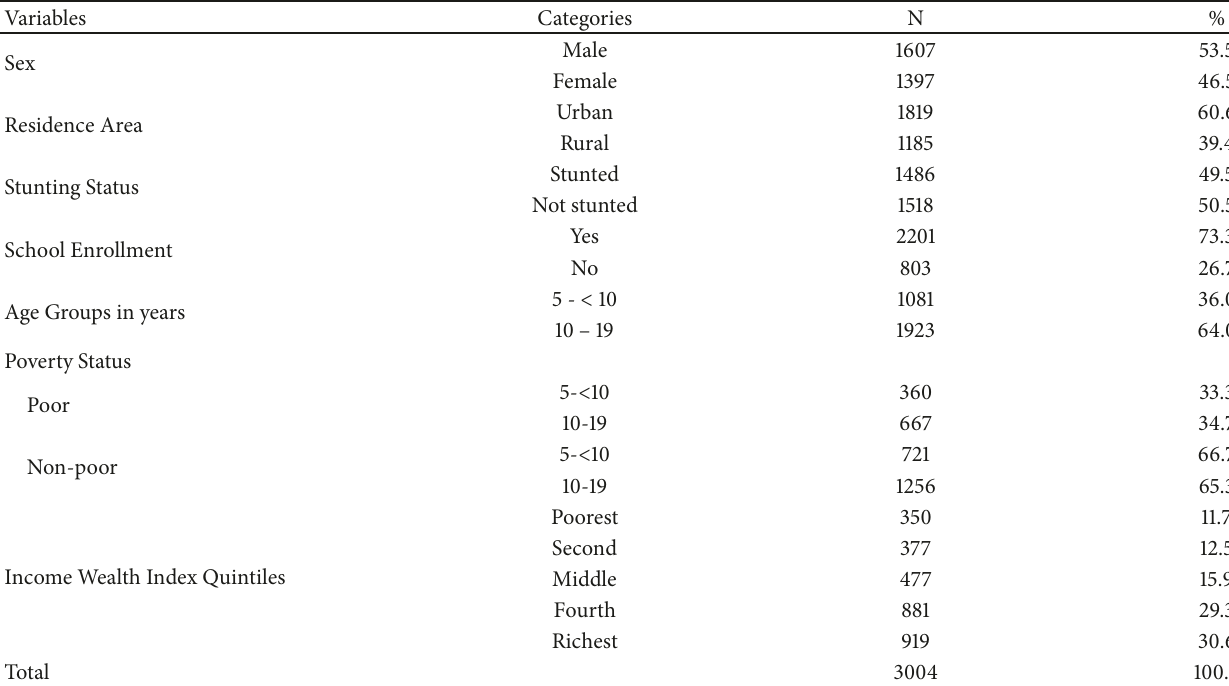
Table 1: Frequencies of the